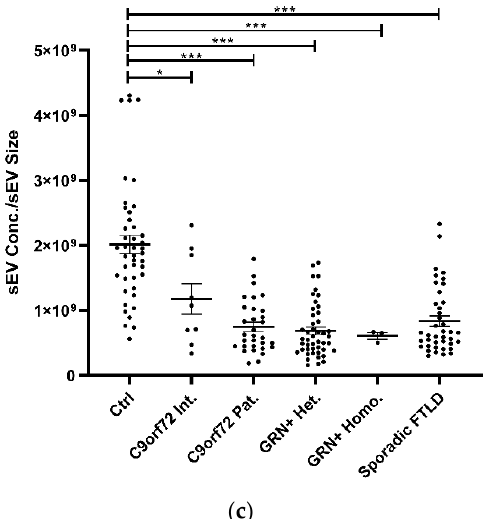
Figure 1. Analysis of plasma sEV concentration and size by NTA in patient and control groups. ( a ) sEV concentration (sEVs/mL), ( b ) sEV size (nm), and ( c ) sEV concentration/sEV size ratio in Ctrl, C9orf72 Int., C9orf72 Pat., GRN + Het., GRN + Homo., and Sporadic FTLD groups. Mean ± SEM; * p < 0.05, ** p < 0.01, *** p < 0.001 obtained by generalized linear model (adjusted for age) for non-normally distributed variables (sEV concentration and sEV concentration/sEV size ratio) or by linear model (adjusted for age) for normally distributed variable (sEV size).